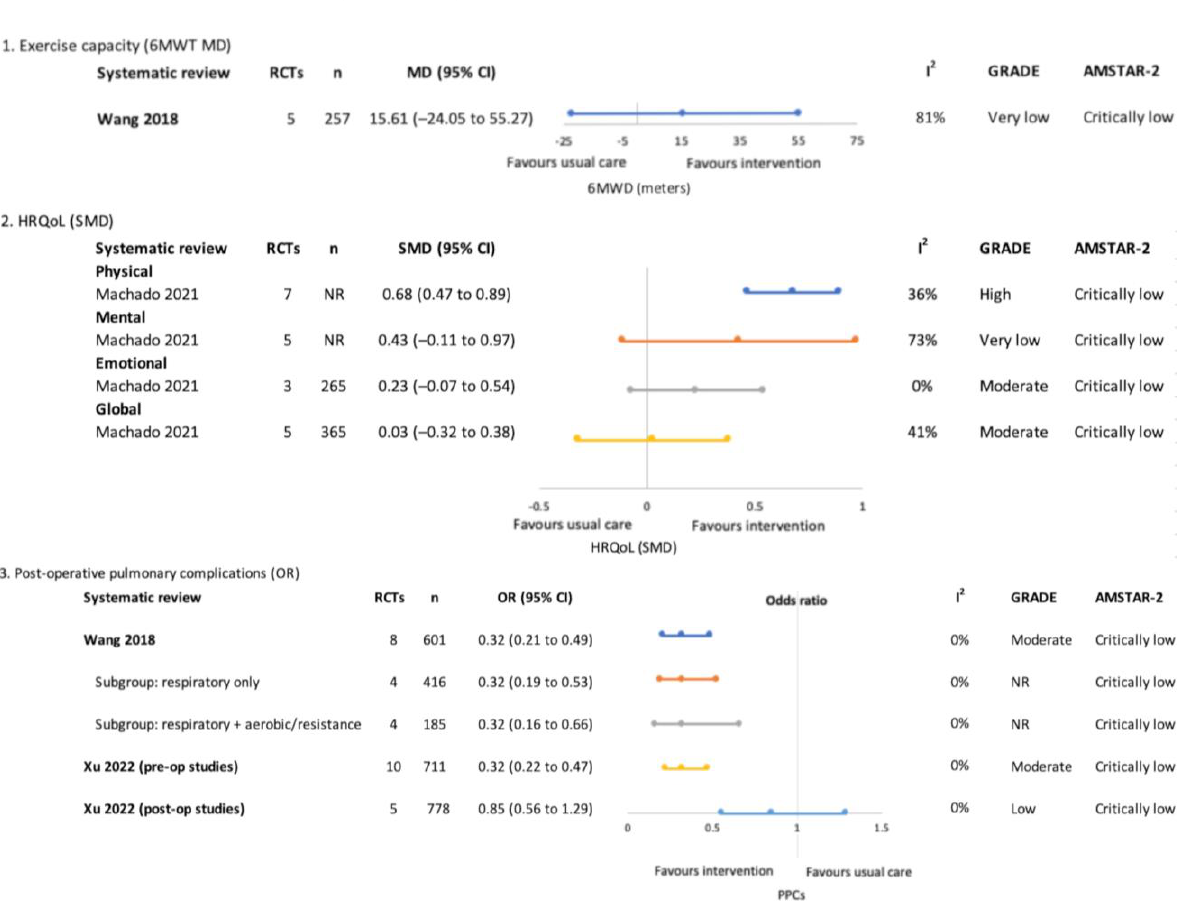
Figure 5. Pre and post-treatment (surgical) – meta-analysis findings for overview primary outcomes (1. Exercise capacity, 2. HRQoL and 3. Post-operative pulmonary complications)